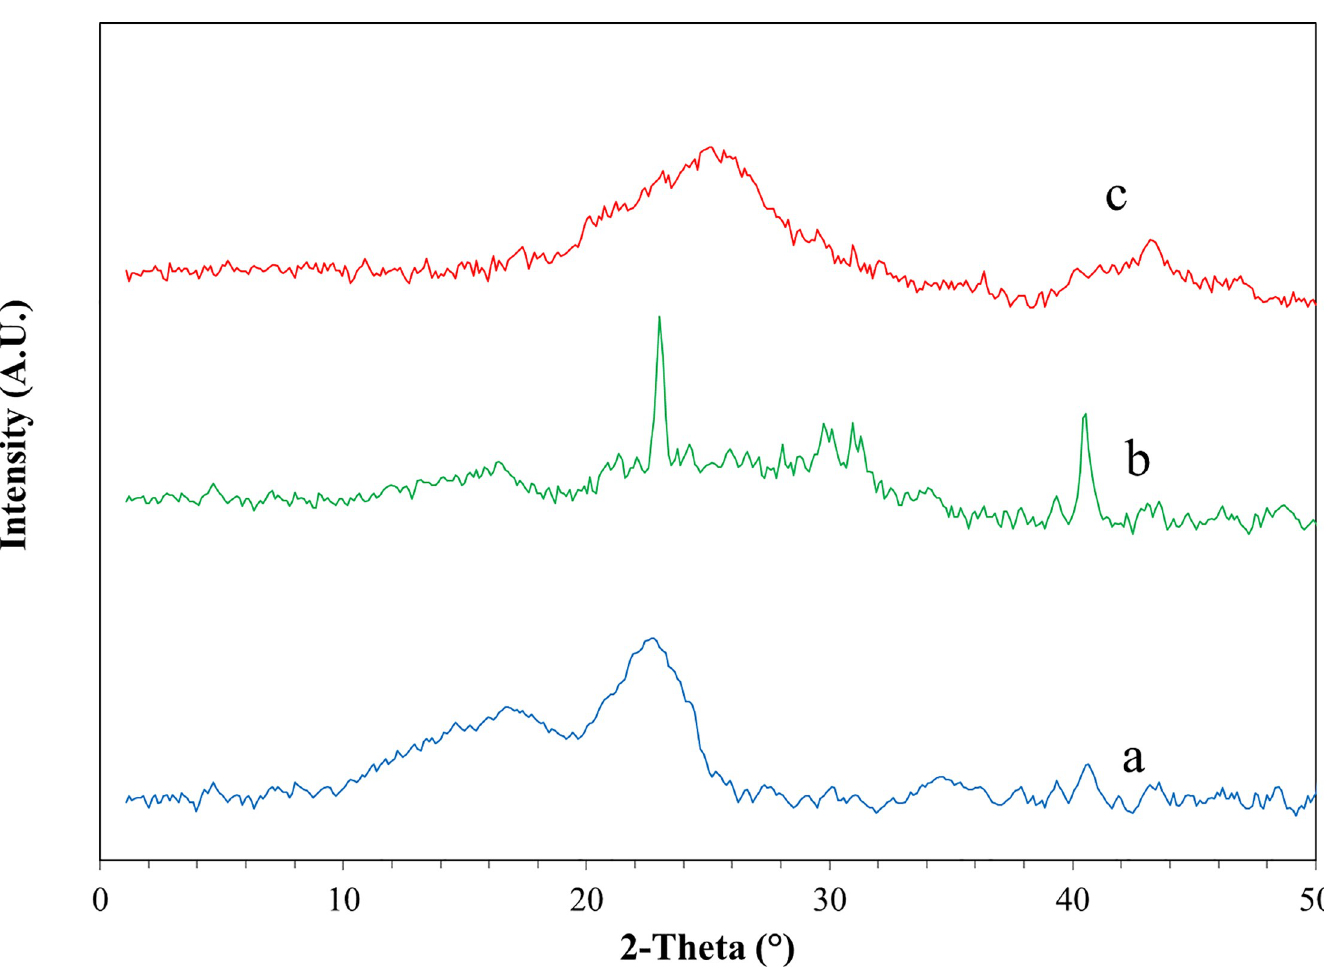
Fig 2. The XRD images of (a) raw corn stover (b) combusted corn stover at 275˚C (CCS) and (c) bio graphene.